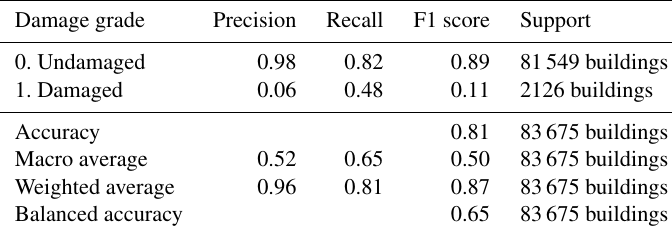
Table 9. Test-set performance metrics for binary classification for the 2020 Zagreb earthquake.